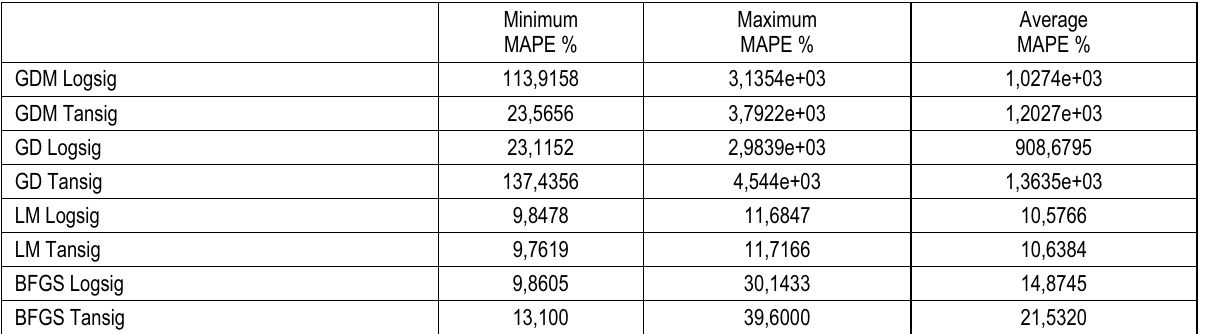
Table 4. Price forecasting algorithms MAPE results